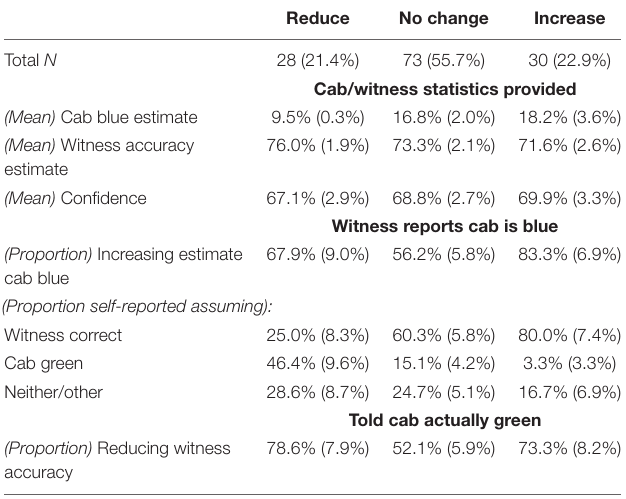
TABLE 1 | Participant responses to a range of questions sub-divided by their initial response to altering the witness’s accuracy.